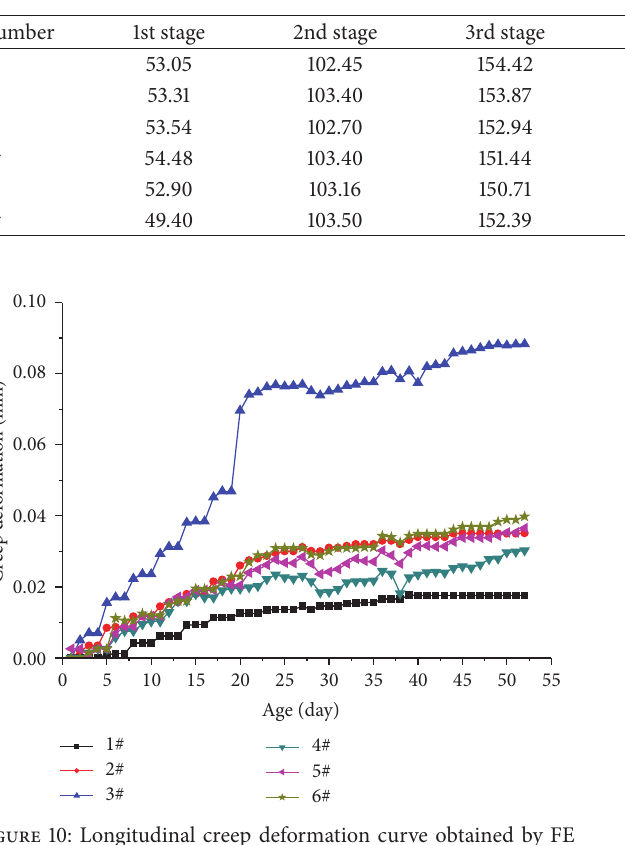
Table 7: Registered load at each stage (kN).